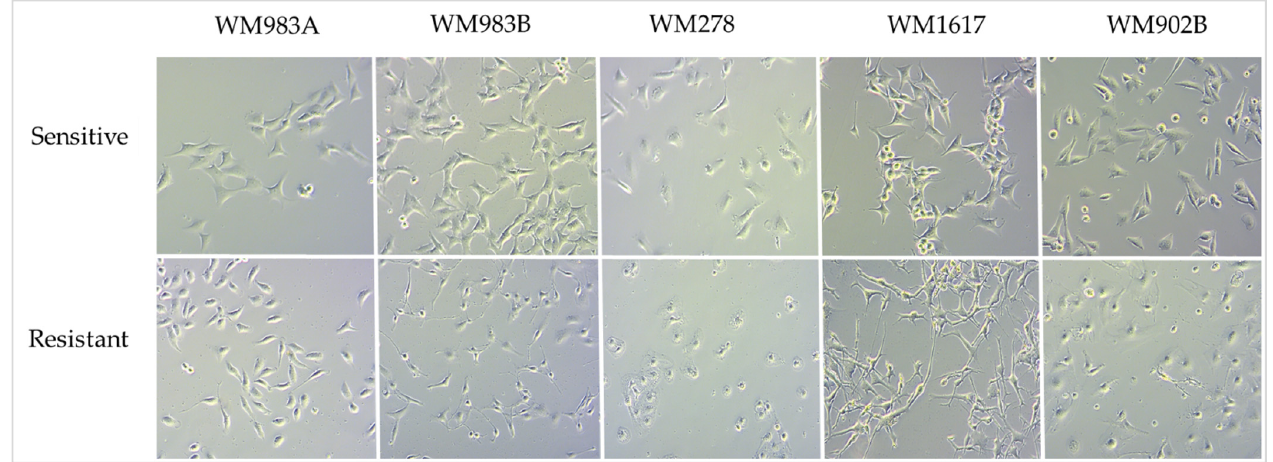
Figure 2. Photomicrographs of the ENCO+BINI-sensitive ( upper panel) and ENCO+BINI-resistant ( lower panel) melanoma cell lines. All images were captured at 100x magnification.